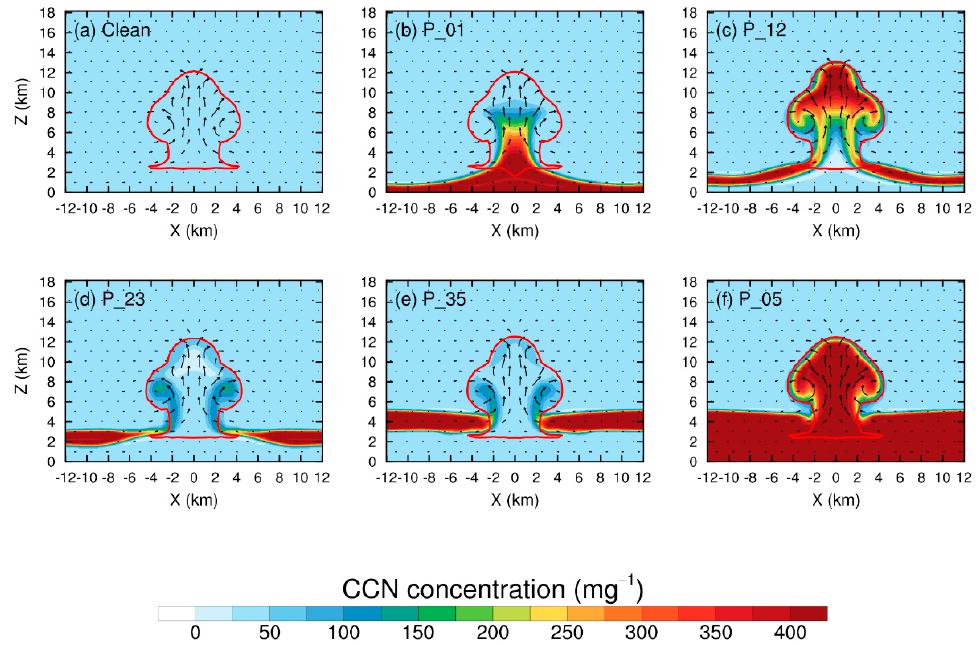
Figure 2. The vertical cross-sections of the deep convective cloud across the domain center at 20 min in the ( a ) Clean, ( b ) P_01, ( c ) P_12, ( d ) P_23, ( e ) P_35 and ( f ) P_05 simulations respectively. The colored shading represents the concentrations of CCN (including both inactivated and activated CCN). The arrows represent the wind field and the arrow length is proportional to wind speed. The red lines are the contours of 1.0 g kg − 1 total mixing ratio of hydrometeors. In the P_01 simulation, where the aerosol layer is below the thermal bubble initially, as the bubble lifts and convection develops, aerosols are pumped into the cloud by up-